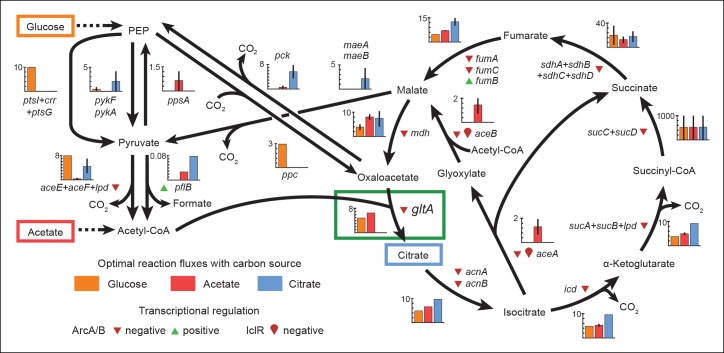
Optimal reaction fluxes on carbon sources present in the E. coli LTEE.Flux balance analysis (FBA) was used to predict the reaction fluxes in the E. coli B REL606 ancestral strain of the LTEE that optimize the rate of biomass accumulation when utilizing a single carbon source: either glucose, acetate, or citrate. Glucose is the primary carbon source for cells grown under LTEE conditions, while acetate, a metabolic overflow product excreted during E. coli growth on glucose, can also be utilized by the ancestral strain (Yoon et al., 2012). Citrate can only be utilized under the aerobic conditions of the LTEE after the Cit+ innovation (Blount et al., 2008, 2012). Flux values derived from FBA for key reactions in central metabolism are shown for modeling growth on each carbon source: glucose (orange bars), acetate (red bars), and citrate (blue bars). Error bars show the full range of possible fluxes for each reaction that are consistent with globally optimal FBA solutions, as predicted by flux variability analysis, and the colored bars show an intermediate value in each range. Gene names for all enzymes that contribute to each reaction flux are displayed. Genes whose expression is controlled by IclR and ArcAB are marked with symbols indicating the direction of transcriptional regulation, and the key citrate synthase (CS) reaction catalyzed by GltA is boxed in green. The results of the FBA modeling agree with our experimental observations that the combined effects of derepressing the IclR and ArcAB regulons via the iclR and arcB mutations and alleviating NADH-mediated allosteric inhibition of CS via the gltA1 mutation are beneficial for growth on acetate because they increase flux values for these reactions toward levels that are optimal for this substrate. This metabolic program is thought to potentiate the evolution of Cit+ by increasing the production of C4-dicarboxylates (succinate, fumarate, and malate) which can be exported in exchange for citrate uptake by the CitT antiporter. Under Cit++ conditions in which citrate is the primary carbon source FBA predicts that drastically reducing flux through the CS reaction is required to achieve an optimal growth rate which also agrees with our finding that beneficial gltA2 mutations that decrease CS activity evolved at this point in the LTEE.